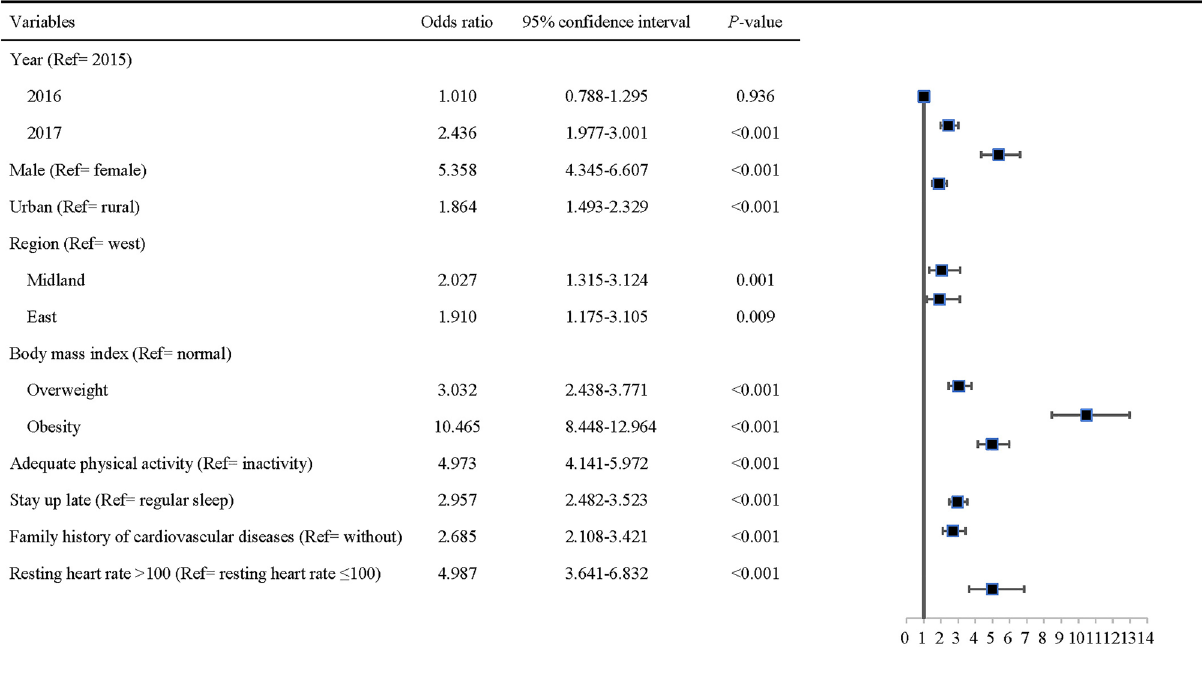
Figure 1. Factors associated with hypertension of college freshmen in multivariable logistic regression